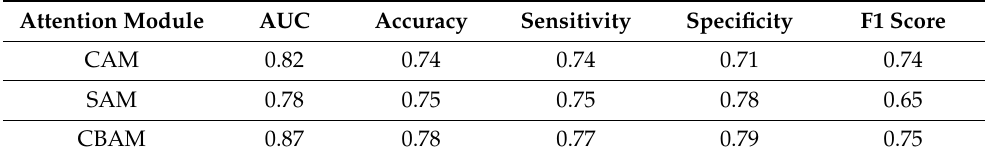
Table 3. Comparison of breast lesion classification results of three transfer learning ResNet50 fine- tuned by adding three different attention